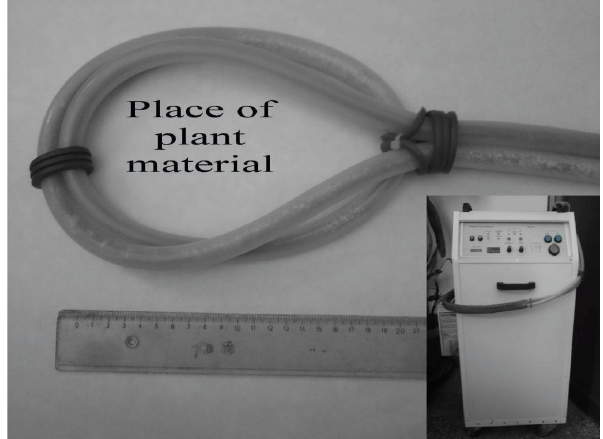
Fig. 5. PAPIMI device and external